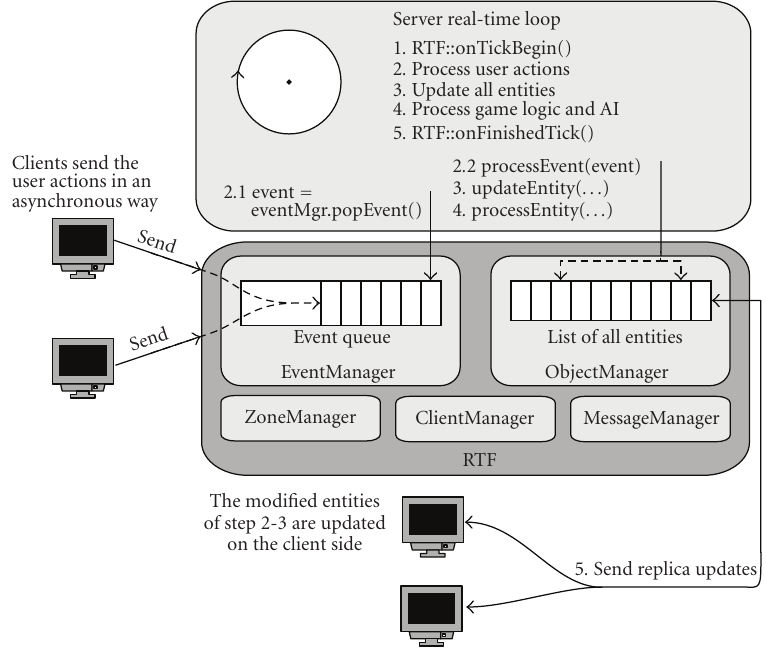
Figure 8: Server side game state processing integration with